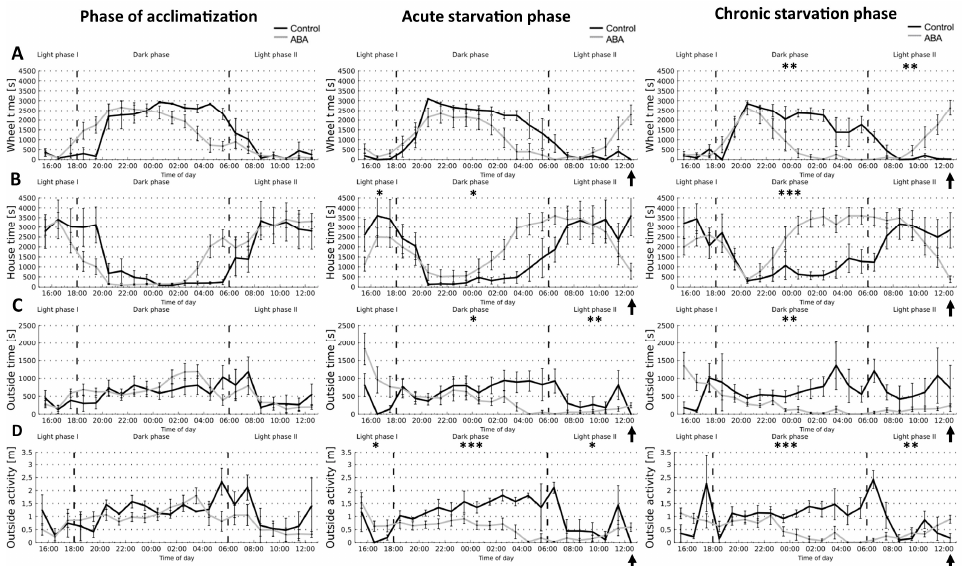
Figure 6. Starvation induces decreased circadian-rhythm-related activity at night. The different parameters, id est ( A ) wheel time, ( B ) house time, ( C ) outside time, and ( D ) outside activity, were measured with the tracking system Goblotrop during acclimatization, acute starvation, and chronic starvation in adolescent ABA ( n = 8) and corresponding control mice ( n = 4). Daily at 1 p.m., food was provided to the mice (marked with arrows). * p ≤ 0.05, ** p ≤ 0.01, *** p ≤ 0.001, two-way ANOVA with repeated measurements.